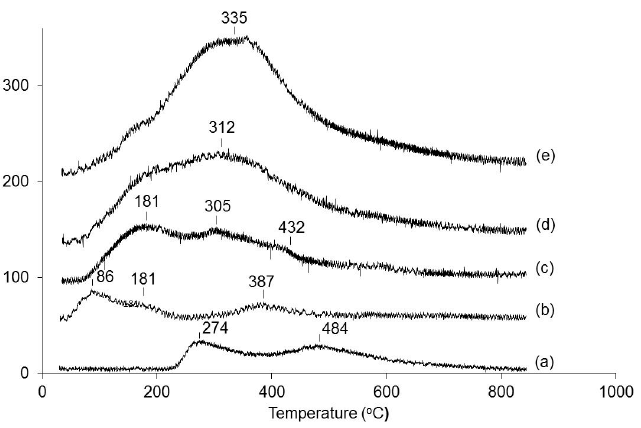
Figure 2. NH 3 -TPD pro fi les of (a) ZSM-5_80, (b) ZSM-5_280, (c) 2% P-ZSM-5_280, (d) 10% P-ZSM-5_280, and (e) 20% P-ZSM-5_280. Table 7. Acidity measurements of various solid acid catalysts by NH 3 -TPD.